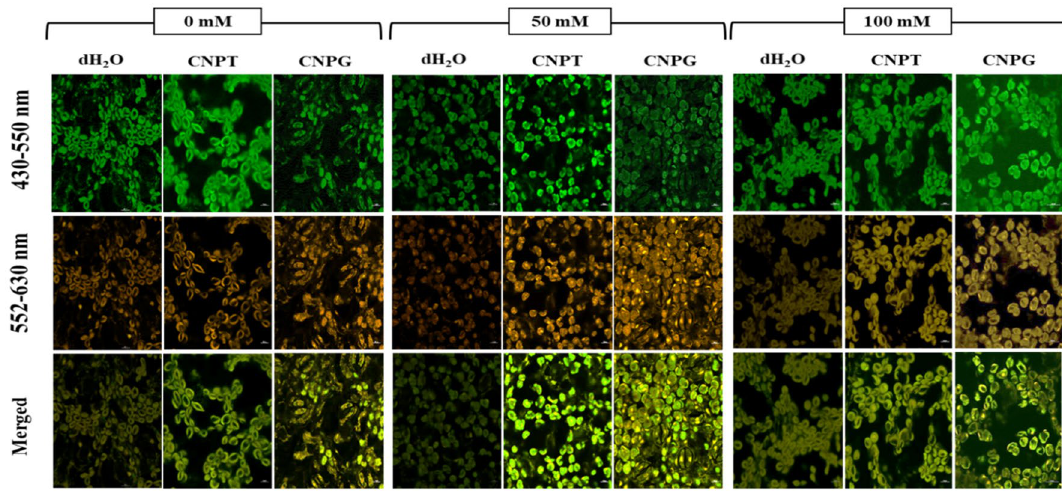
Figure 7. Confocal microscopy images (60 ×) showing the uptake of carbon-nanodots into the mesophyll cells treated with CNPT and CNPG solution. Excitation was done at 488 nm and emission was captured at 430– 550 nm (Green—showing the fluorescence of mesophyll cells) and 552–630 nm (Red—showing the fluorescence of uptaken CNDs). The merged images also show the fluorescence of